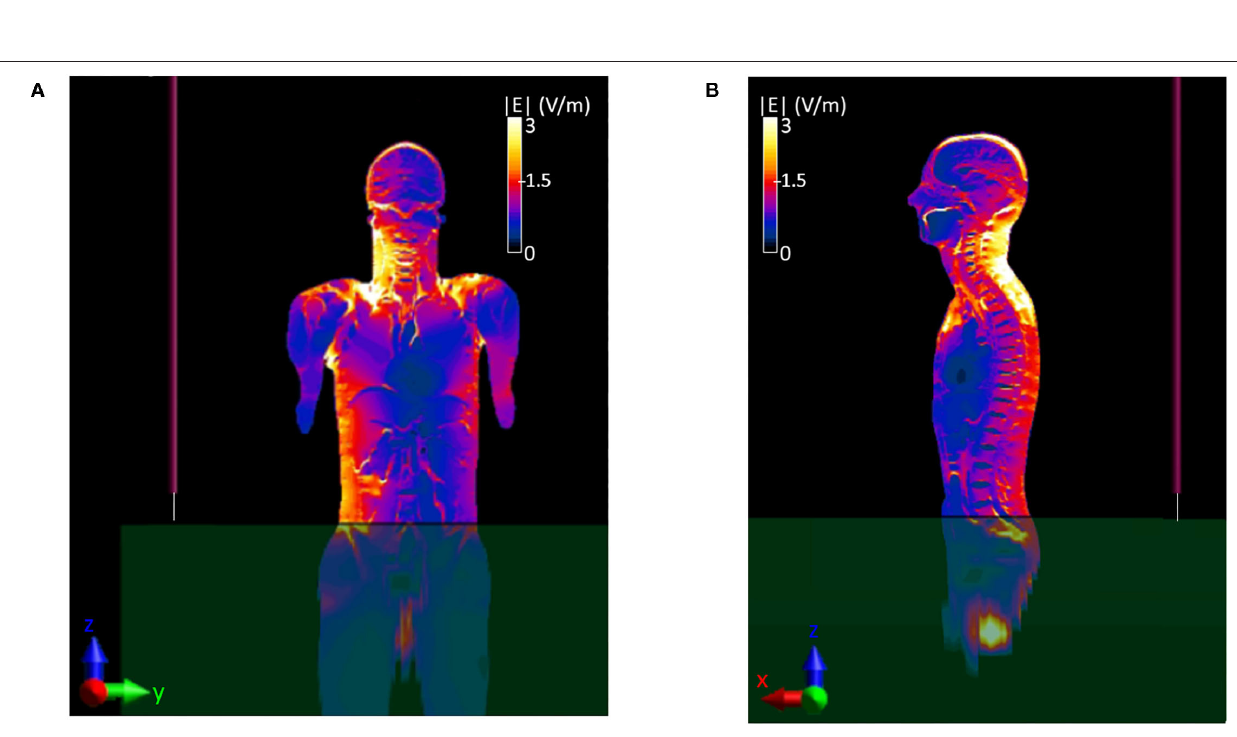
Frontiers in Public Health |